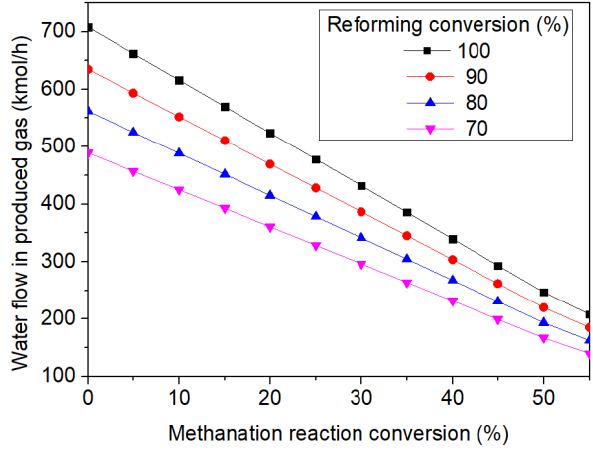
Figure 5. Molar flow of water evaporated in APR reactor vs. reforming and methanation conversion.